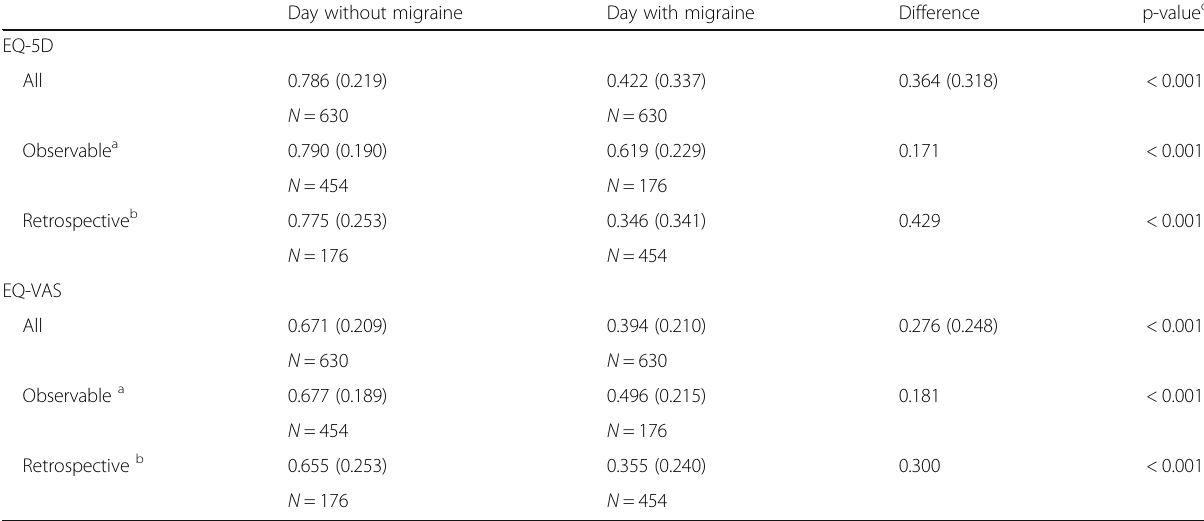
Table 3 Mean quality of life a day with migraine and a day without migraine Day without migraine Day with migraine Difference p-value c